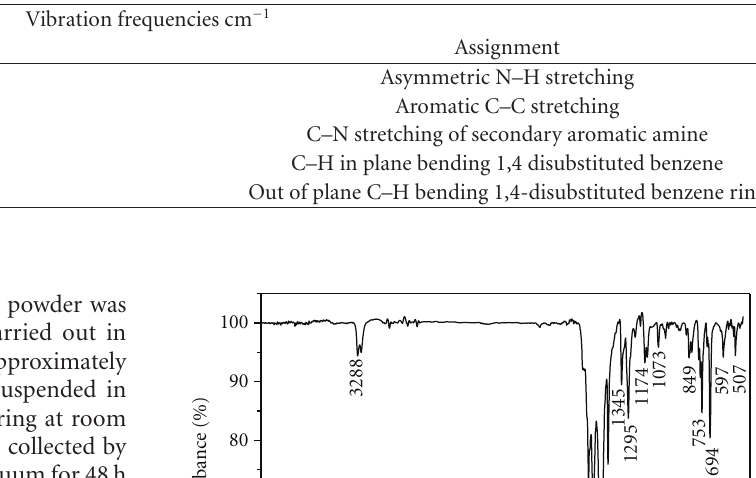
Table 1: The vibration frequencies of PANI-ES and PANI-EB.